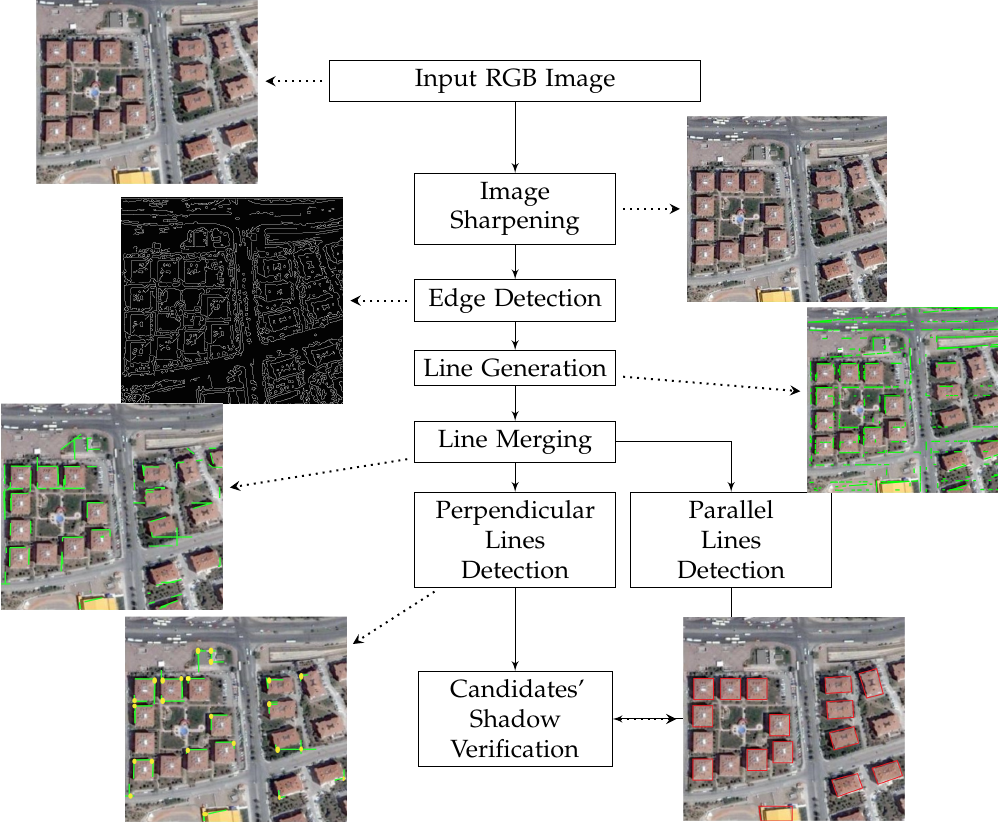
Figure 3. The flat building detection ( FBD )